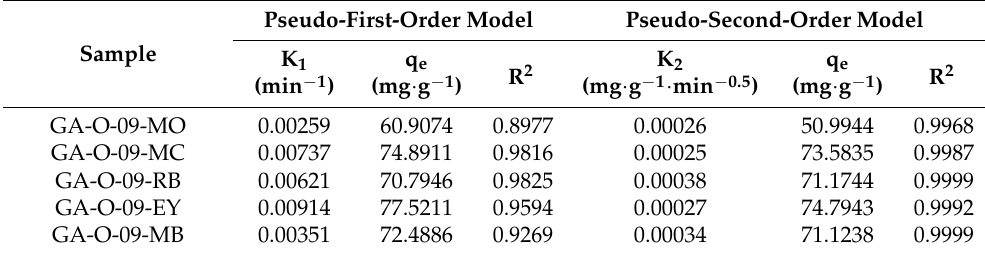
Figure 9. ( a ) Real-time monitoring of dyes absorption by GA-O-09/Cu 2+ hydrogel; ( b ) pseudo-first-order kinetic plots of GA-O-09/Cu 2+ hydrogel; ( c ) pseudo-second-order kinetic plots of GA-O-09/Cu 2+ hydrogel; ( d ) Real-time monitoring of dyes absorption by GA-O-09 hydrogel; ( e ) pseudo-first-order kinetic plots of GA-O-09 hydrogel; ( f ) pseudo-second-order kinetic plots of GA-O-09 hydrogel. Table 1. Rate constants of two different kinetic models for hydrogels during adsorption of dyes with different charges.